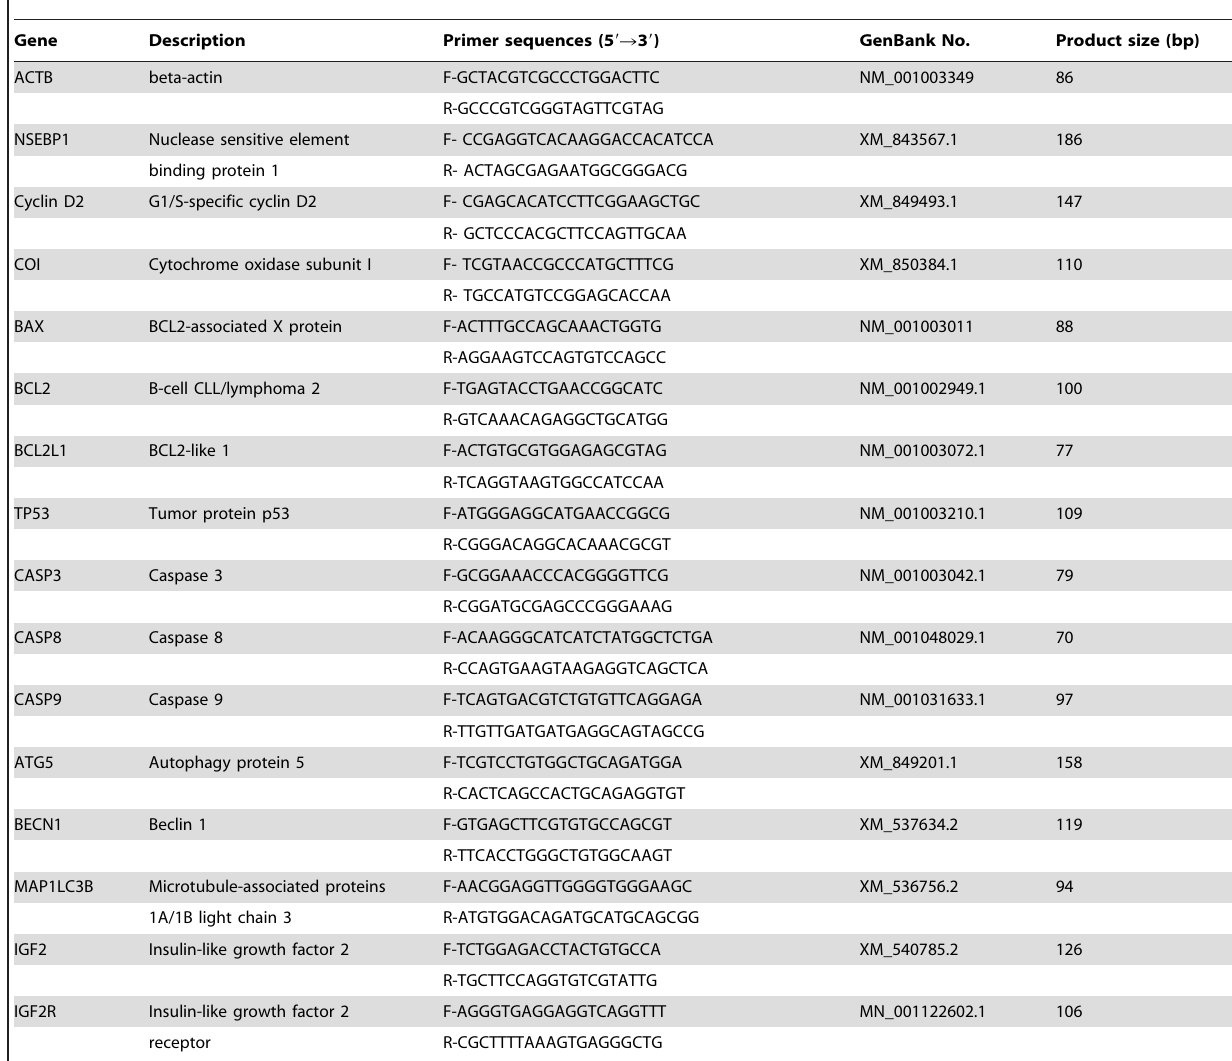
Table 1. List of sequence-specific primers used for real-time